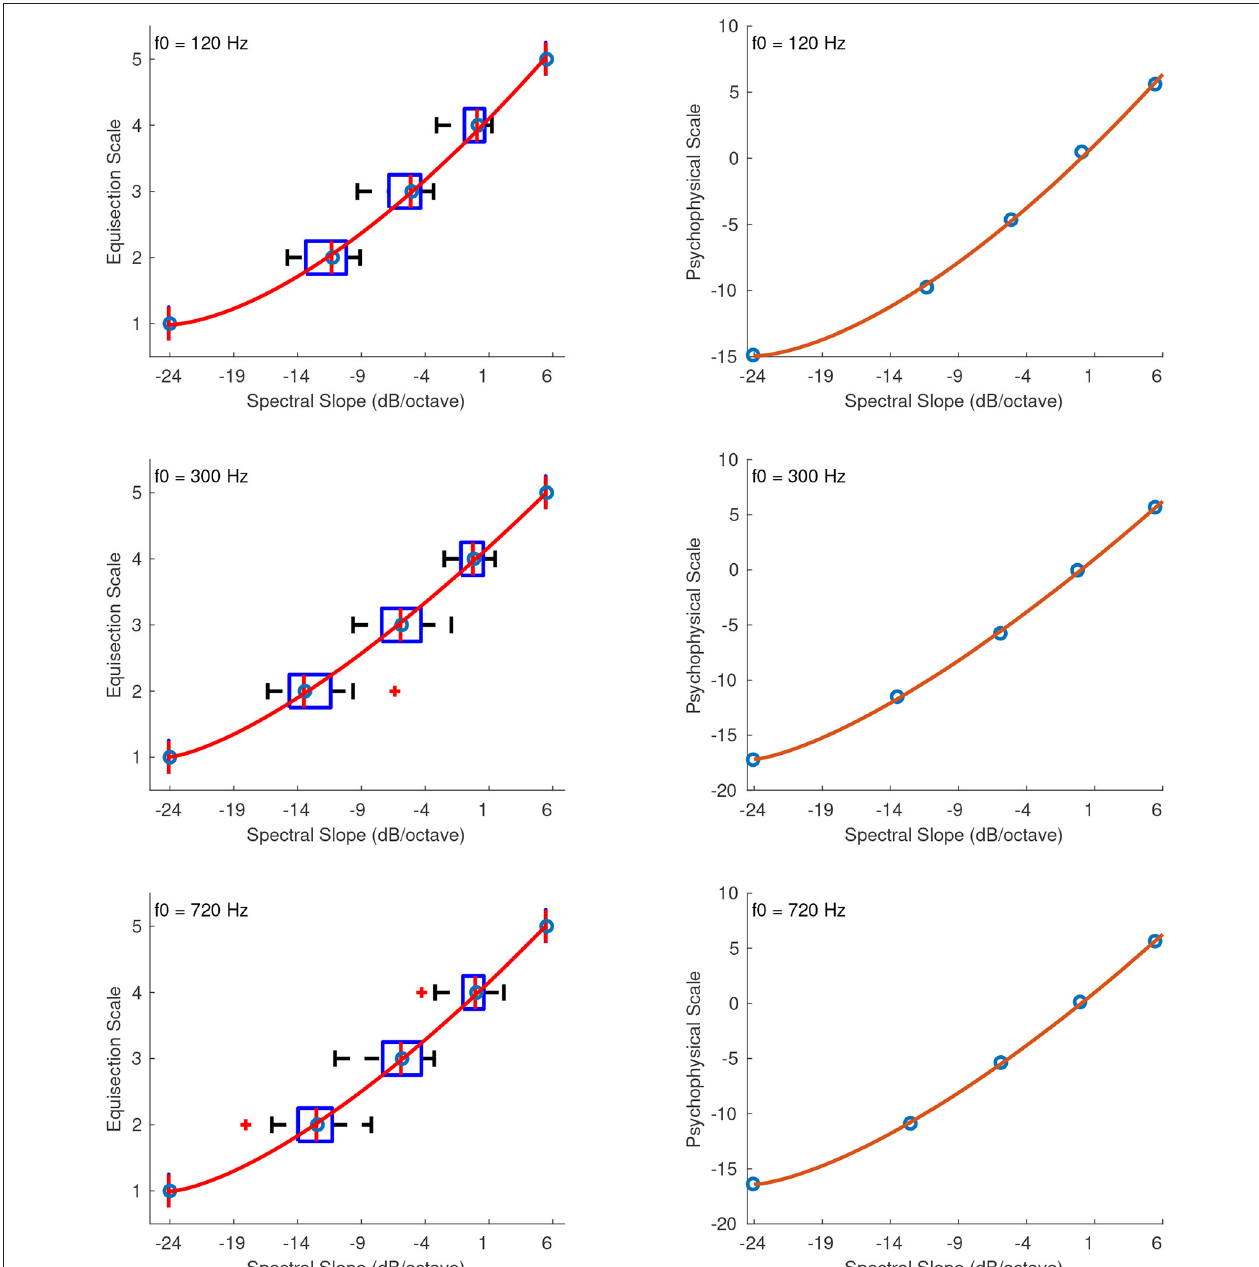
FIGURE 14 | Equisection and psychophysical scales of spectral slope at three f0s. Left panels, boxplots and fitting functions on the median ratings. Whiskers extend to 2.7 SD. Right panels, psychophysical scales and extrapolated fitting functions.